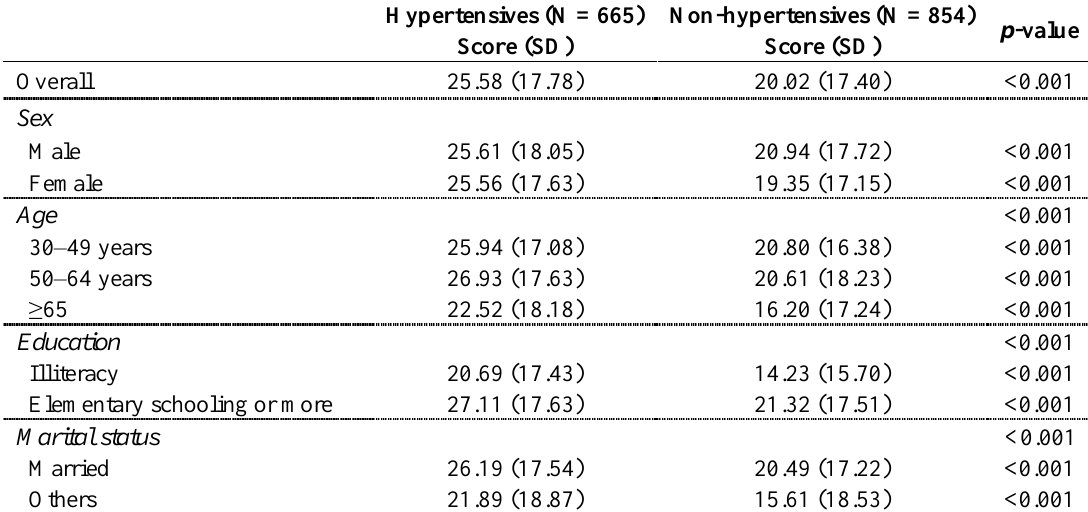
Table 3. Average hypertension knowledge score (standard deviation, SD) out of the maximum